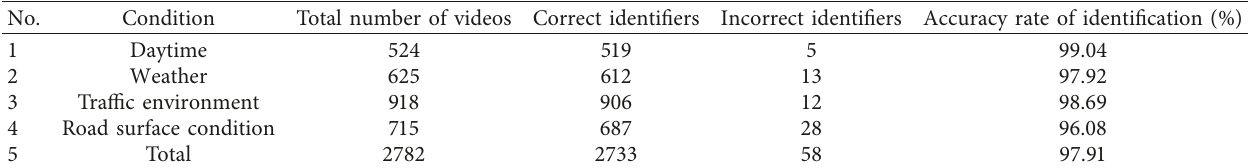
Figure 20: Several wrong lane detection results for different conditions: (a) shade and (b) good lighting due to inappropriate ROI. Table 4: Results of lane detection for different conditions with TuSimple